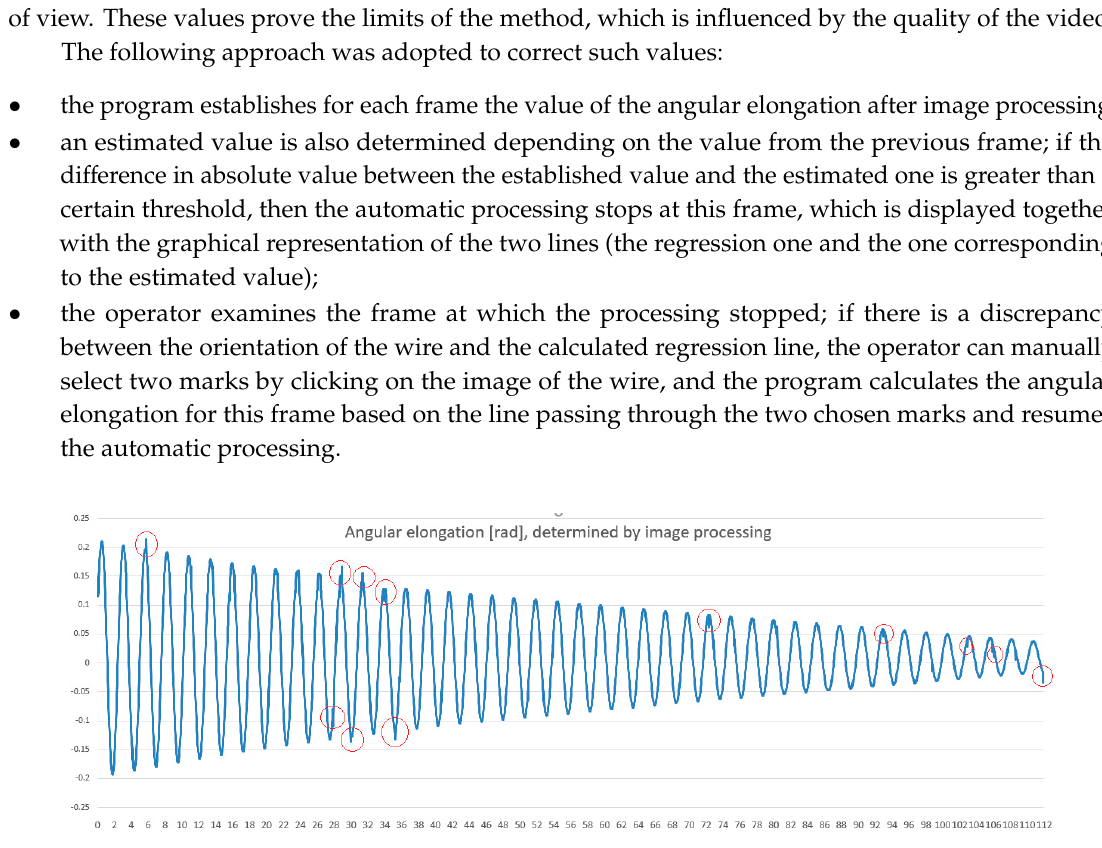
Figure 12. Plot of the angular elongation variation versus time as resulted in the first stage of image processing program elaboration.